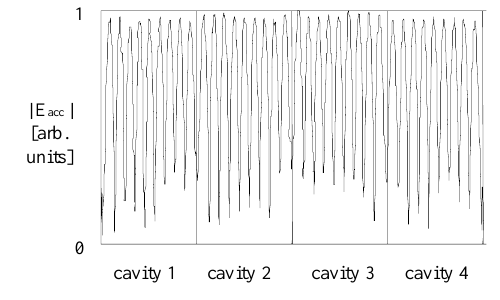
FIG. 8. The measured field profile in the preprototype of the superstructure.